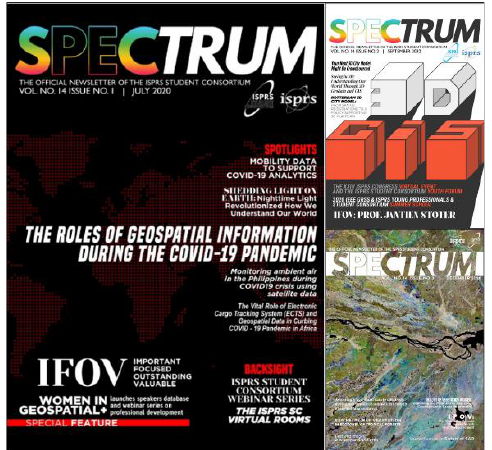
Figure 7 . The three issues of the SpeCtrum published for volume